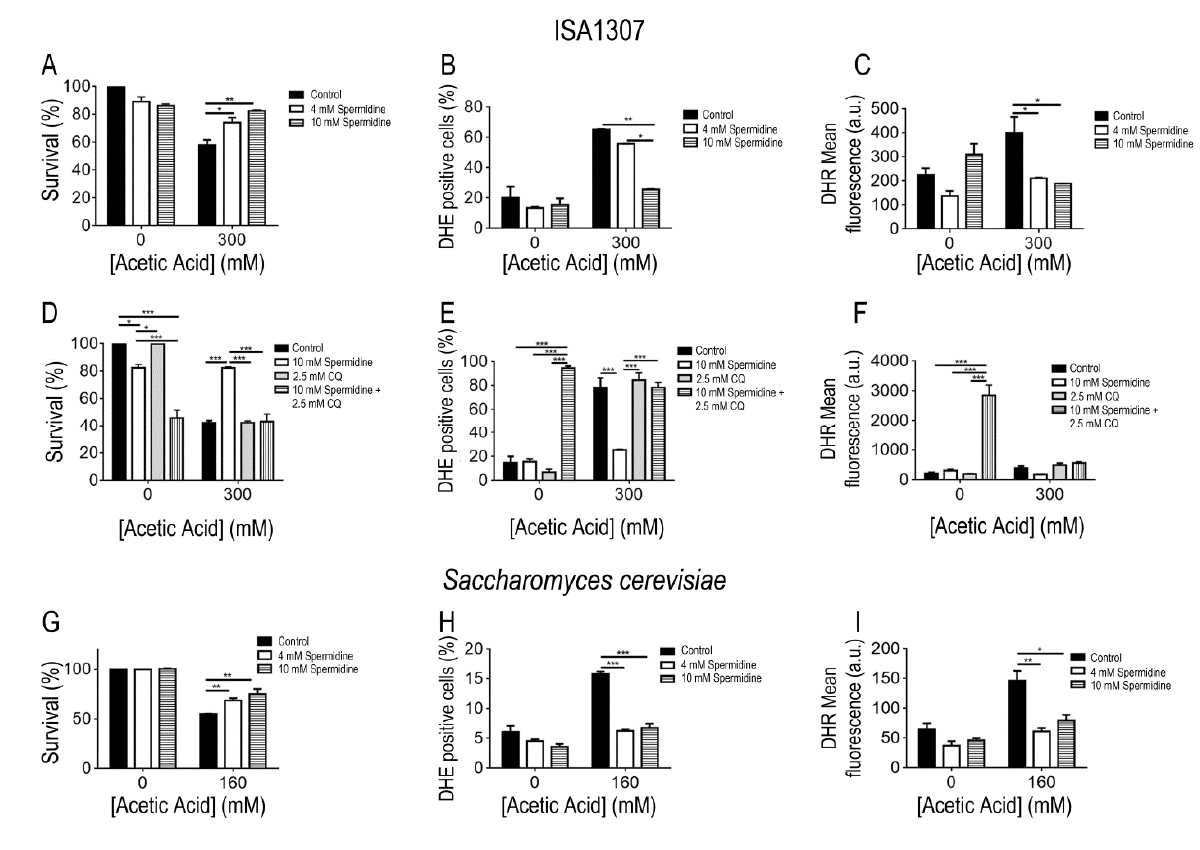
FIGURE 5: Spermidine protects cells from acetic acid - induced PCD. Comparison of the survival rate of (A) ISA1307 and (G) Saccharomyces cerevisiae cells treated with the described concentration of acetic acid combined with 4 mM or 10 mM spermidine. FACS measurements of superoxide anions ( B and H ) using the probe dihydrioethidium and hydrogen peroxide ( C and I ) using the probe dihydrorhodamine 123 (DHR) in ISA1307 and S. cerevisiae cells, respectively. (D) Survival rate and FACS measurements of (E) superoxide anions and (F) hydrogen peroxide (DHR) of ISA1307 cells treated with 300 mM of acetic acid combined with 10 mM spermidine and the autophagy inhibitor chloroquine (CQ) at 2.5 mM. Bar graphs indicate mean and standard error of the mean (SEM). Fluorescence/cell (arbitrary units) measured in 25,000 cells/sample in three independent experiments. Significance of the data was determined by two-way ANOVA (*P < 0.05; **P < 0.01; ***P <